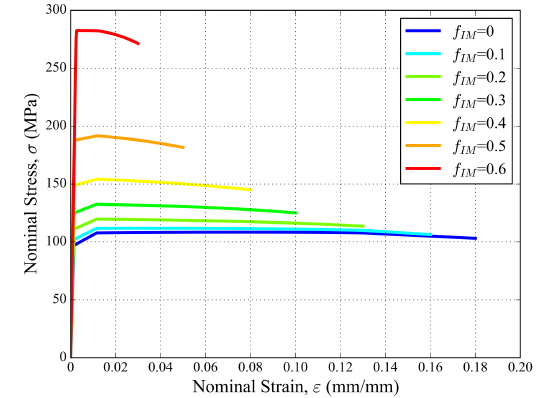
Figure 5. Tensile stress–strain curves of aluminum matrix materials including GTN damage, for increasing fraction of intermetallic particles.